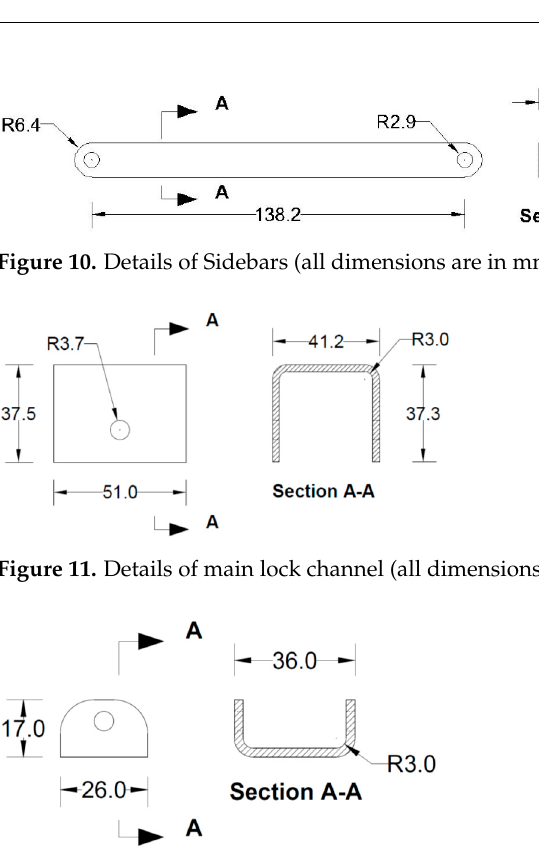
Figure 9. Details of Secondary bars (all dimensions are in mm, steel plate gauge 11).